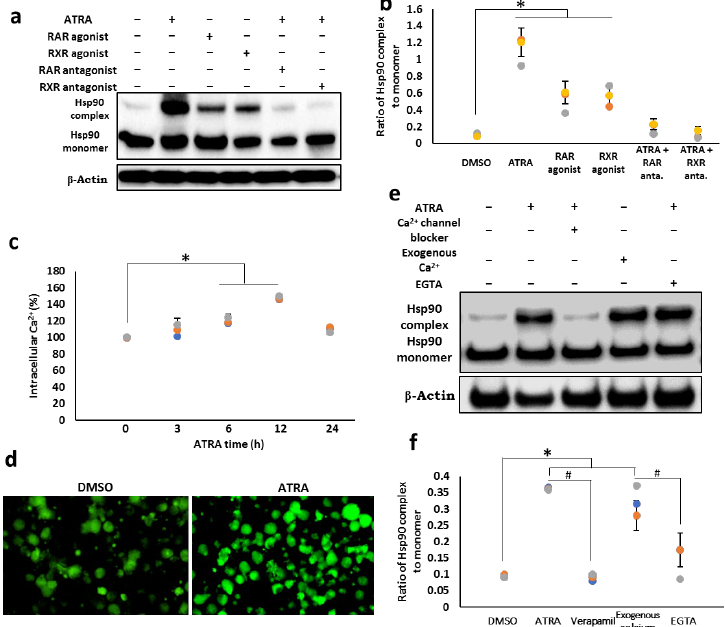
Figure 3. Cell surface Hsp90 complex formation depends on RAR/RXR pathway and intracellular calcium level. ( a , b ) Cell surface Hsp90 complex in the presence or absence of RAR/RXR agonists or antagonists. THP-1 cells were treated with 1 µM RAR or RXR antagonists in the presence of 1 µM ATRA, or with 1 µM RAR or RXR agonists without ATRA for 24 h. Cells were then collected and subjected to cross-linking reaction with BS3. The cell lysates were analyzed by Western blotting. ( c , d ) Intracellular calcium levels. Cells were treated with 1 µM ATRA for various time points as indicated, and the intracellular calcium level was measured by flow cytometry ( c ), or the cells were treated with 1 µM ATRA for 12 h, and the intracellular calcium level was determined by fluorescence microscope ( d ). ( e , f ) Cell surface Hsp90 complex in the presence or absence of calcium channel blocker or the chelator. Cells were treated with either the calcium channel blocker, verapamil or the chelator, ethyleneglycoltetraacetic acid (EGTA), in the presence of 1 µM ATRA or with 2.5 mM exogenous calcium without ATRA. Cells were then collected and subjected to the cross-linking reaction. The cell lysates were analyzed by Western blotting. ( b , f ) Densitometric analysis of protein bands was performed with the ChemiDoc MP Imaging System (n = 4). The ratios of Hsp90 oligomer/monomer were calculated, and the data were normalized to the DMSO control. The ratio of oligomer/monomer from the control group was set as 100%. Statistical analysis was performed between control and treated groups (n = 3). * p < 0.05; # p < 0.05.